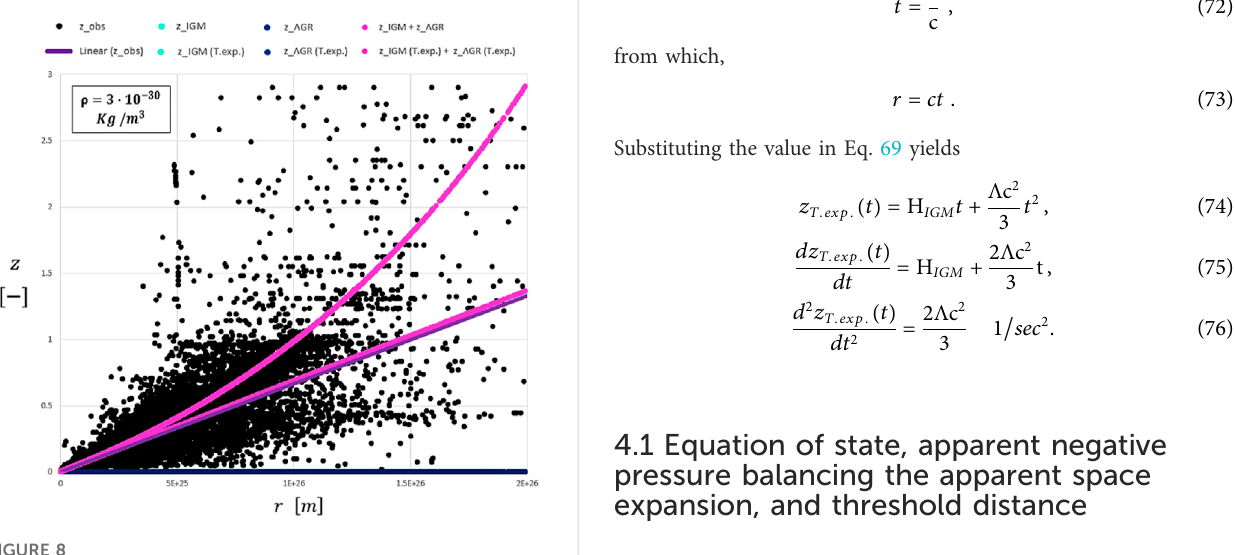
FIGURE 8 Plot of Figure 7 with a smaller average mass density of visible